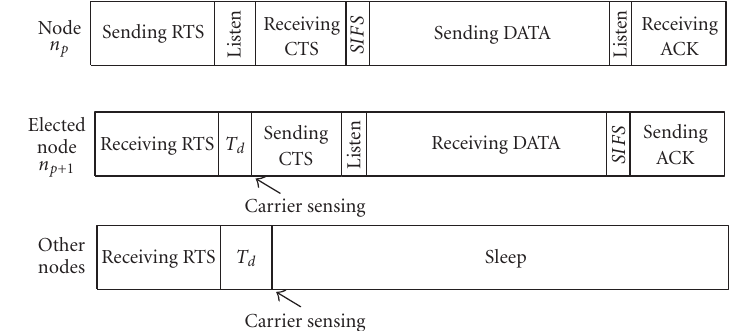
Figure 2: Packet relaying